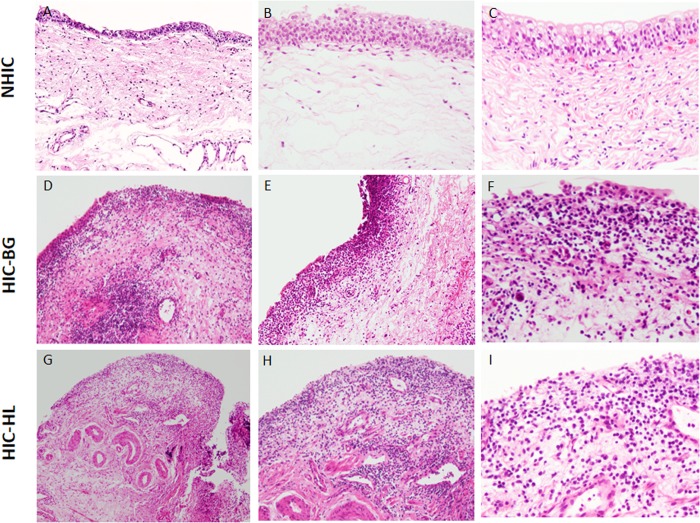
Representative histology of non-Hunner-type interstitial cystitis (NHIC) biopsy specimen.(A) low-power view reveals unremarkable bladder mucosa; (B) overlying epithelium is well preserved; no stromal inflammation is seen; (C) lymphocytes are only occasionally found in the lamina propria. (D–F) Representative histology of the HIC biopsy specimen taken from background (non-Hunner lesion) mucosa (HIC-BG): (D) diffuse inflammatory cell infiltration with focal aggregate of lymphocytes present in the subepithelial layer; (E) dense subepithelial inflammation observed in a linear pattern; (F) inflammatory cells predominantly composed of lymphocytes and plasma cells; epithelium is irregularly denuded. (G–I) Representative histology of the Hunner lesions of patients with HIC: (G) low-power view; (H) subepithelial layer diffusely inflamed; (I) epithelium completely denuded and numerous plasma cells found in the underlying stroma.